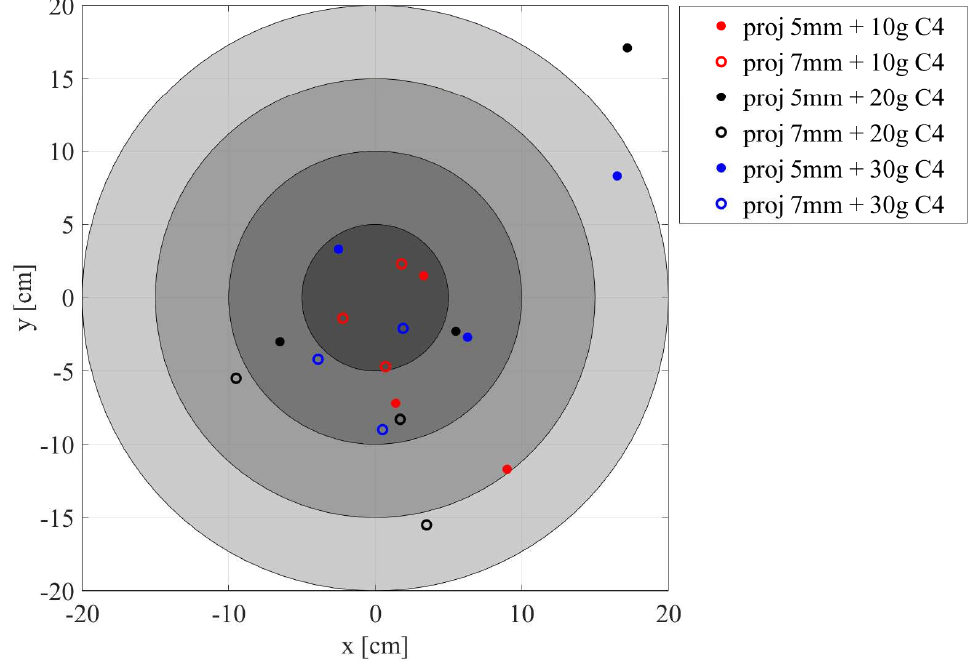
Figure 7. Representation of the dispersion of projectiles impacts using 5 and 7 mm projectile diameters and 10, 20, and 30 g C4 spherical explosive